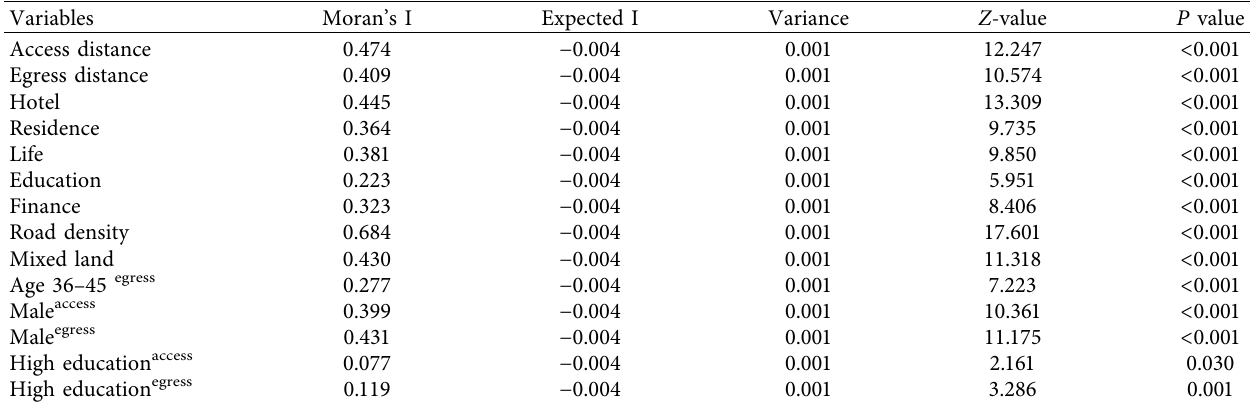
Table 7: Global Moran’s I result of variables.